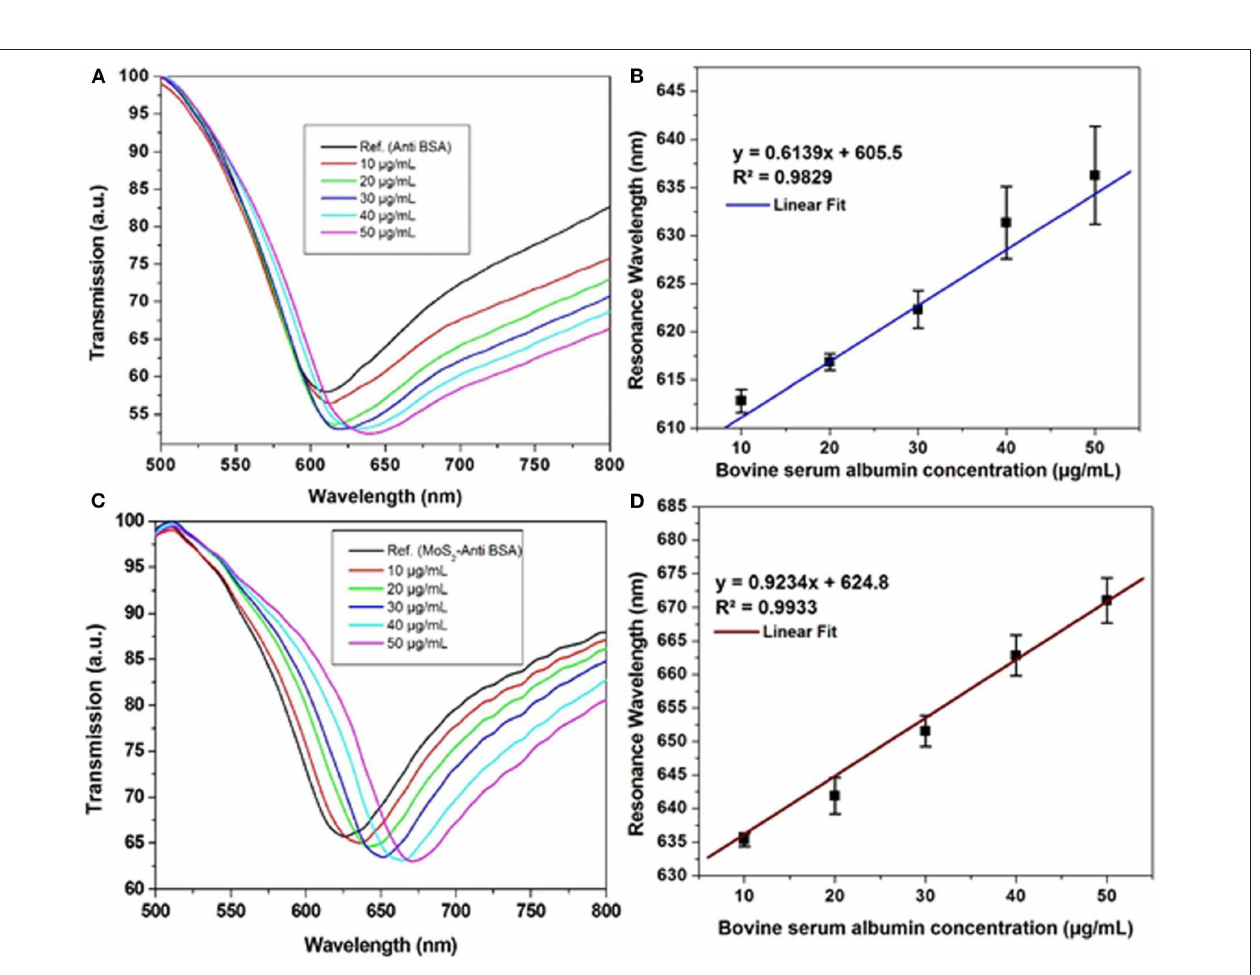
Frontiers in Chemistry |